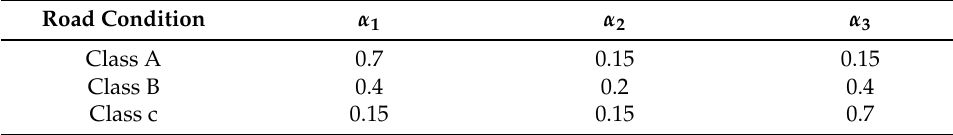
Table 2. Weight coefficient distribution under different road conditions.